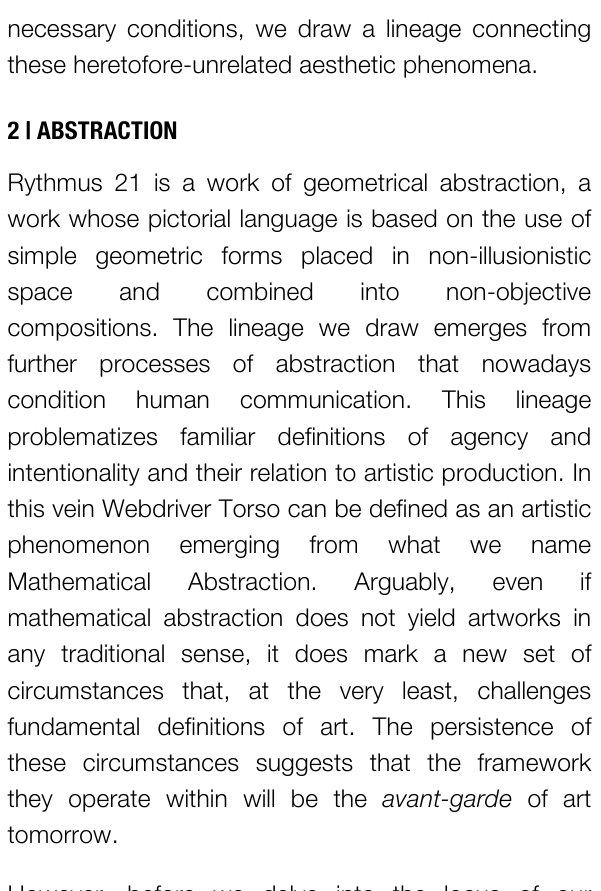
Figure 1 | 1. A still from the film 'Film Ist Rhythm: Rhythmus 21' (1921). Hans Richter.